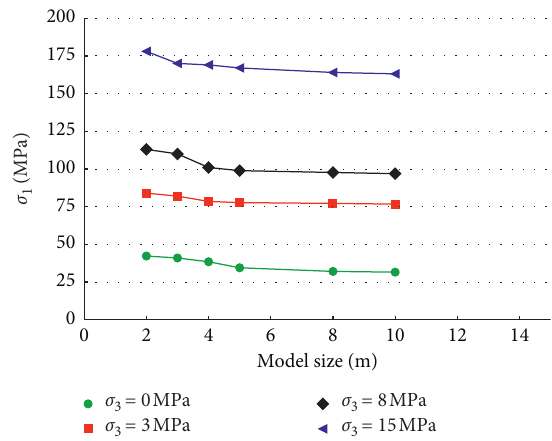
Figure 12: Effect of the confining pressure on peak strengths of specimen